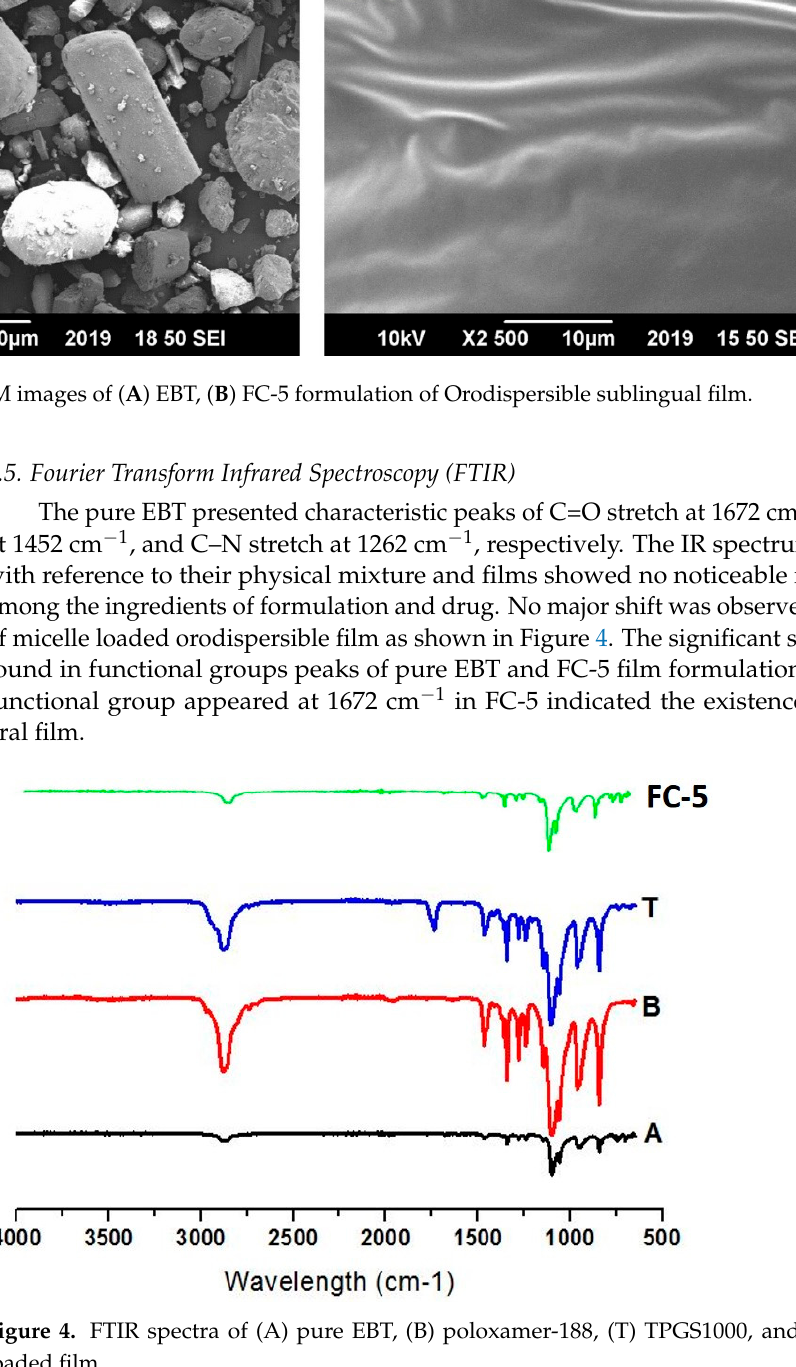
Figure 5. XRD diffractograms (A) EBT drug, (F) blank film, (EBTF) EBT plain film, (FC-5) micelles- loaded film.